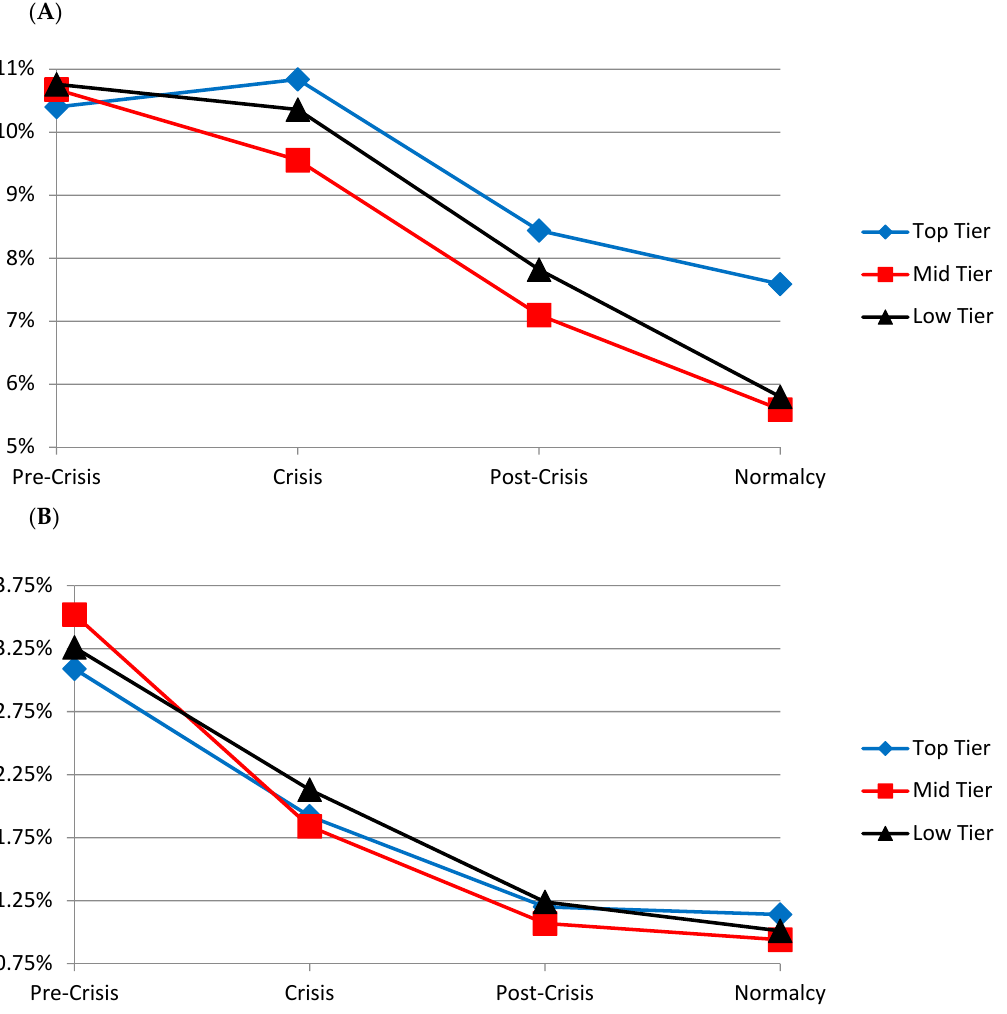
8 of 15 Figure 3. Shareholder Equity/Total Assets Ratio. Notes: Top-Tier: JPMorgan Chase, Bank of America, Citigroup, Wells Fargo; Mid-tier: Bank of New York Mellon, State Street, US Bancorp, PNC Financial Services Group; Low-tier: Capital One Financial, BB&T, SunTrust Banks, Regions Financial. Pre-crisis: 2005–2007; Crisis: 2008–2010; Post-Crisis: 2011–2013; Normalcy: 2014–2016. Data obtained from published financial reports. A related issue is whether some banks enjoy a financing subsidy by virtue of their perceived TBTF status. 22 The logic is that providers of capital to TBTF banks are willing to offer more favorable terms because they anticipate being bailed out in the event of default. Apart from the unfairness aspect of big being favored over small, this could also induce the TBTF banks to take on greater risks since the rewards are reaped by shareholders/managers while catastrophic losses are offloaded on to taxpayers—a classic moral hazard scenario. In Figure 4, we report our estimates of the cost of equity (Panel A) and the weighted average cost of capital (Panel B) for the banks in our sample; the results are quite interesting. Both cost of